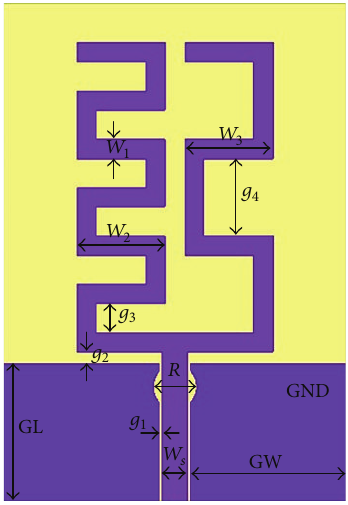
Figure 8: Configuration of reference dual-band antenna.